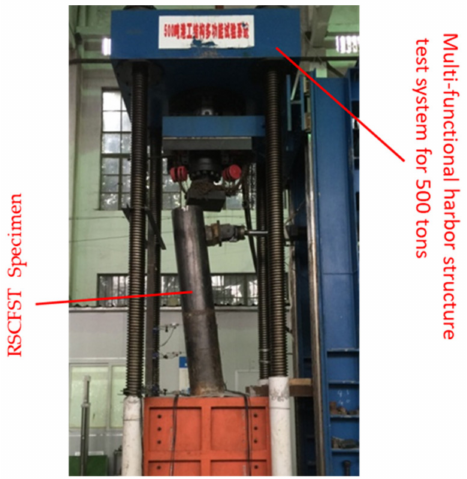
Figure 5. The failure of the